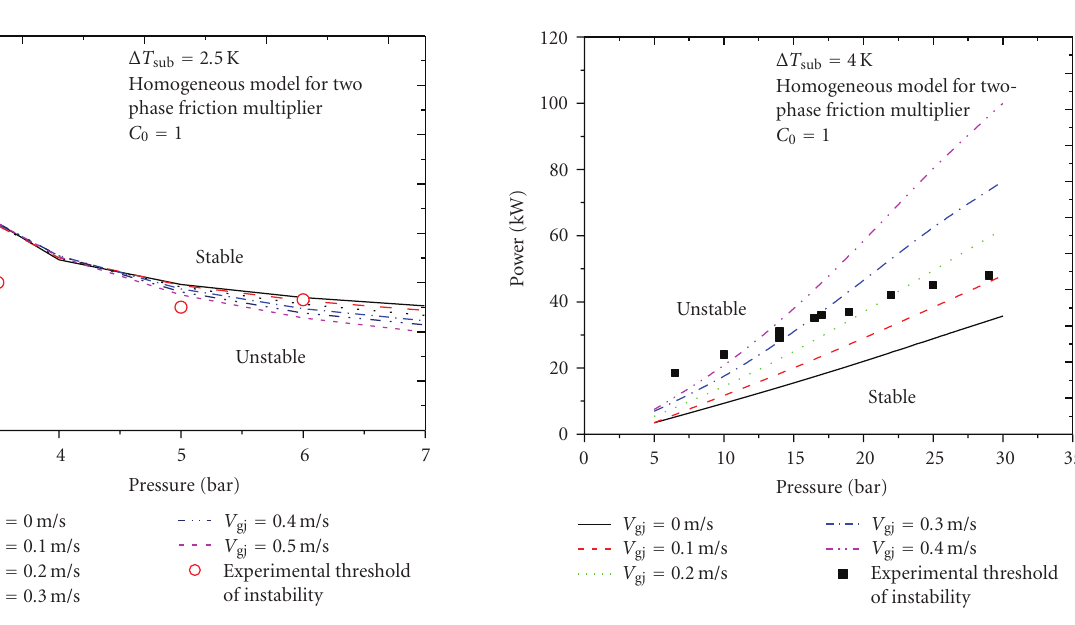
Figure 13: E ff ect of drift velocity on threshold of Type I instability observed in high pressure natural circulation loop (HPNCL).